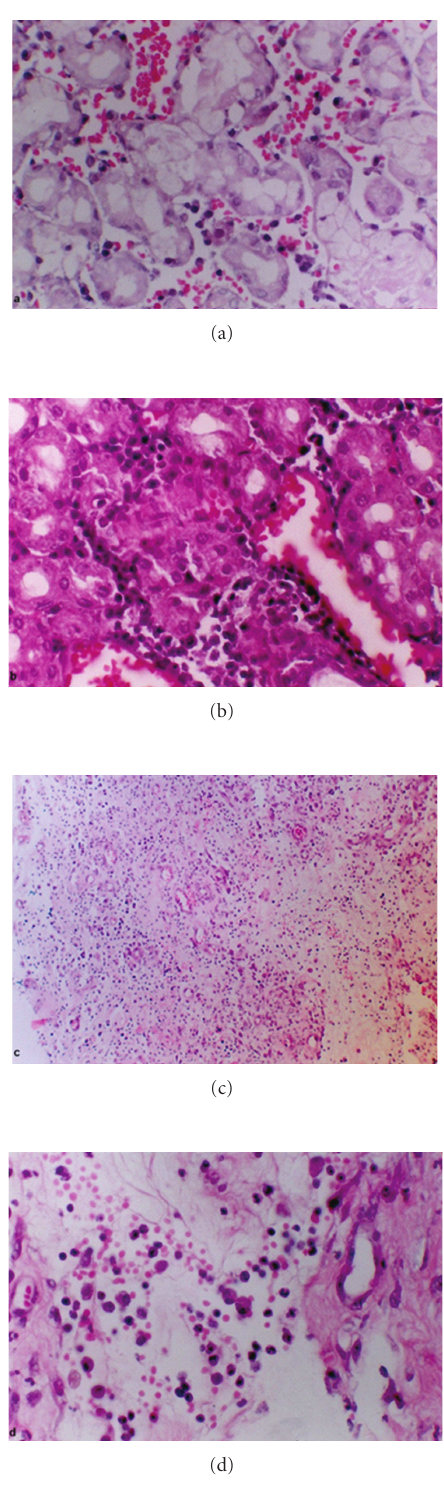
Figure 4: Histopathologic sections of the excised sublingual (a) and mandibular (b) salivary glands indicating mild atrophy and hemorrhage (Hematoxylin and Eosin, × 100). The mucocele wall consisting of connective tissue lining and inflammatory cells is clearly evident (c) (Hematoxylin and Eosin, × 40) alongside the presence of red blood cells and blood vessels (d) (Hematoxylin and Eosin, ×